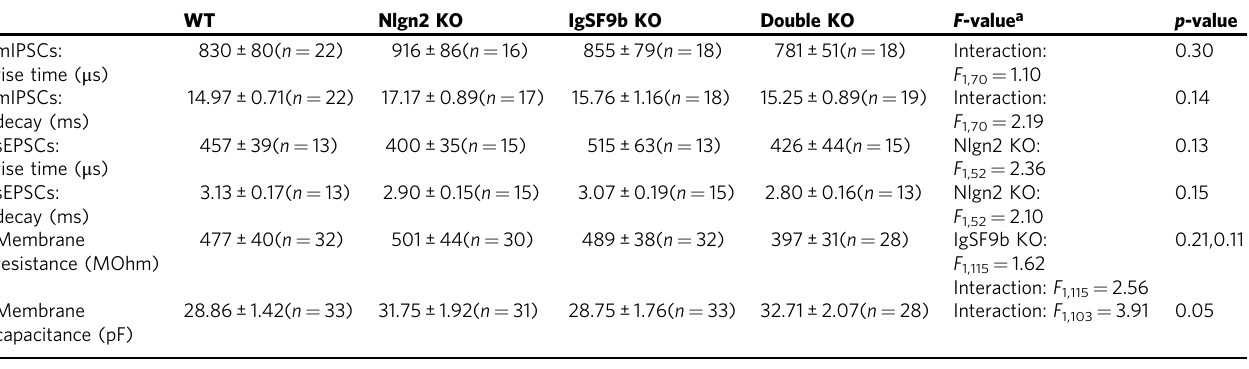
Table 2 Kinetics of PSCs and passive membrane properties of inhibitory neurons in